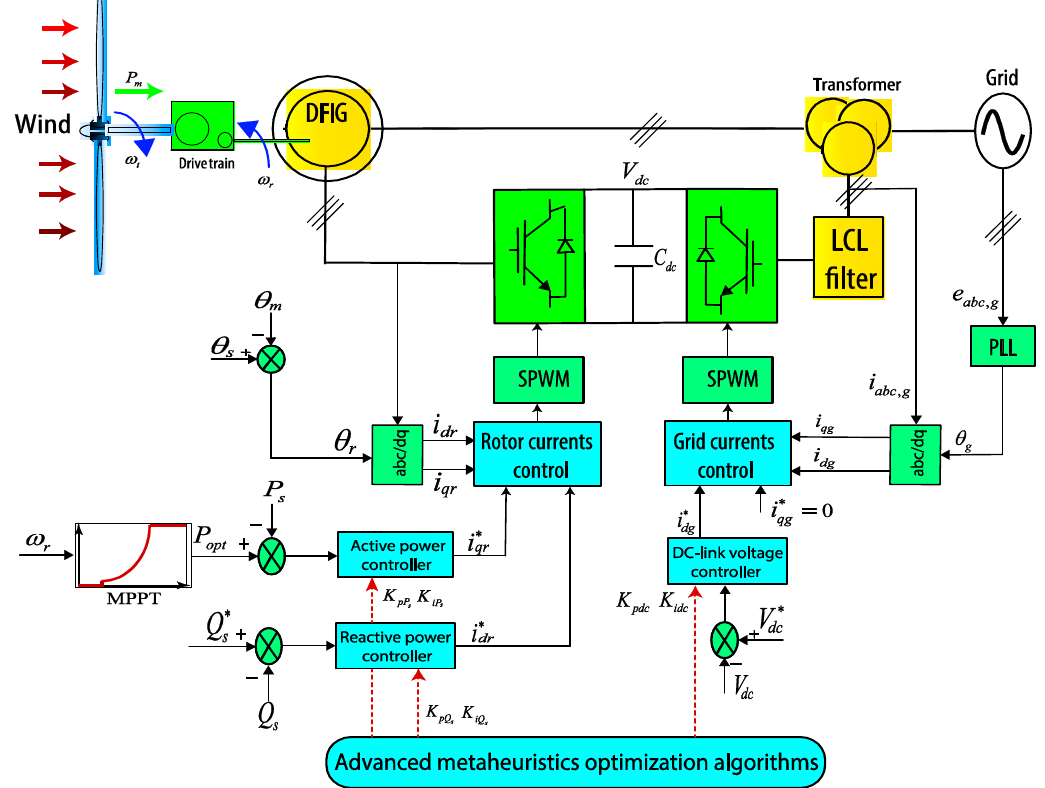
Figure 4. The proposed control algorithm applied to the DFIG system.